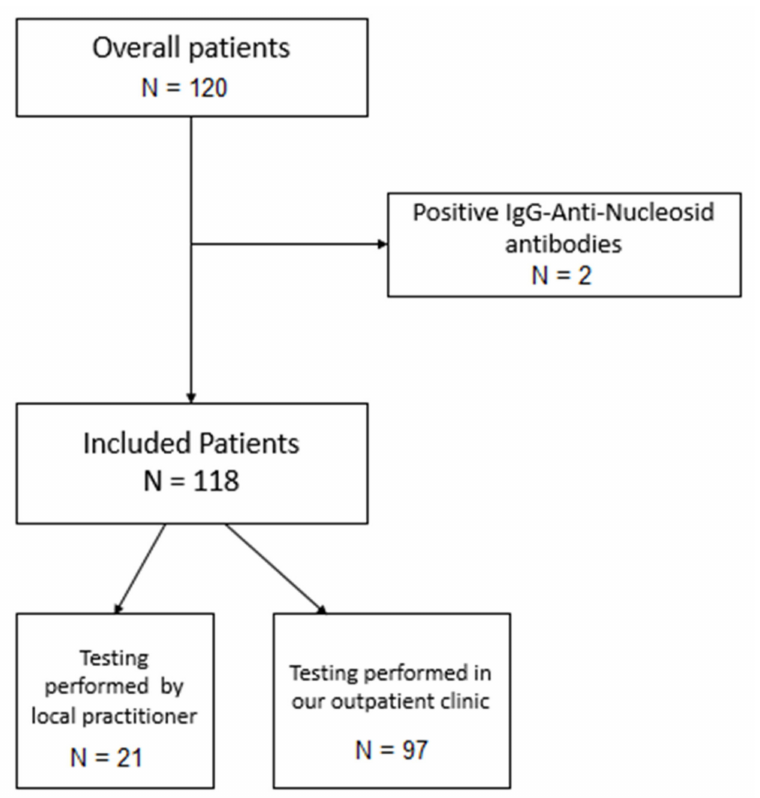
Figure 1. Inclusion process. After exclusion of 2 asymptomatic patients with positive IgG-anti- nucleocapsid antibodies an overall of 118 patients, 97 of them tested at our outpatient clinic and 21 tested by a local practitioner, were included for further